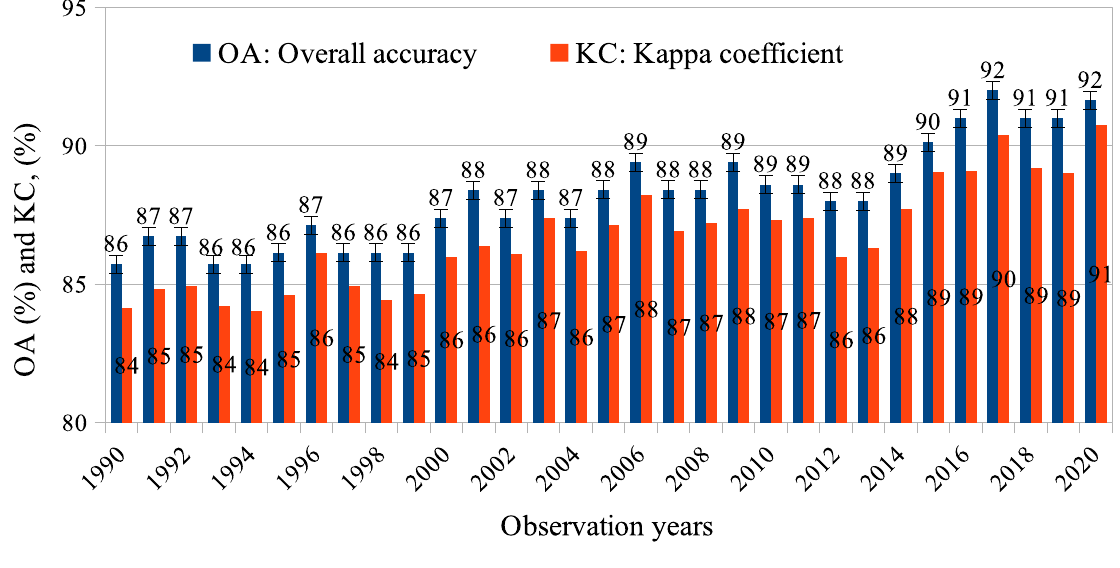
Figure 3. The overall accuracy (OA) and kappa coefficient (KC) of the level-1 Vietnam-wide annual LULC maps produced from the all freely available Landsat TM, ETM + and OLI, and Sentinel SAR GRD and MSI images with the random-forest-based algorithm. The OA and KC are obtained by using a confusion matrix and a stratified validation method with independent samples (1050 points/LULC category). The bars indicate uncertainties of OA measured with a 95% confidence interval.